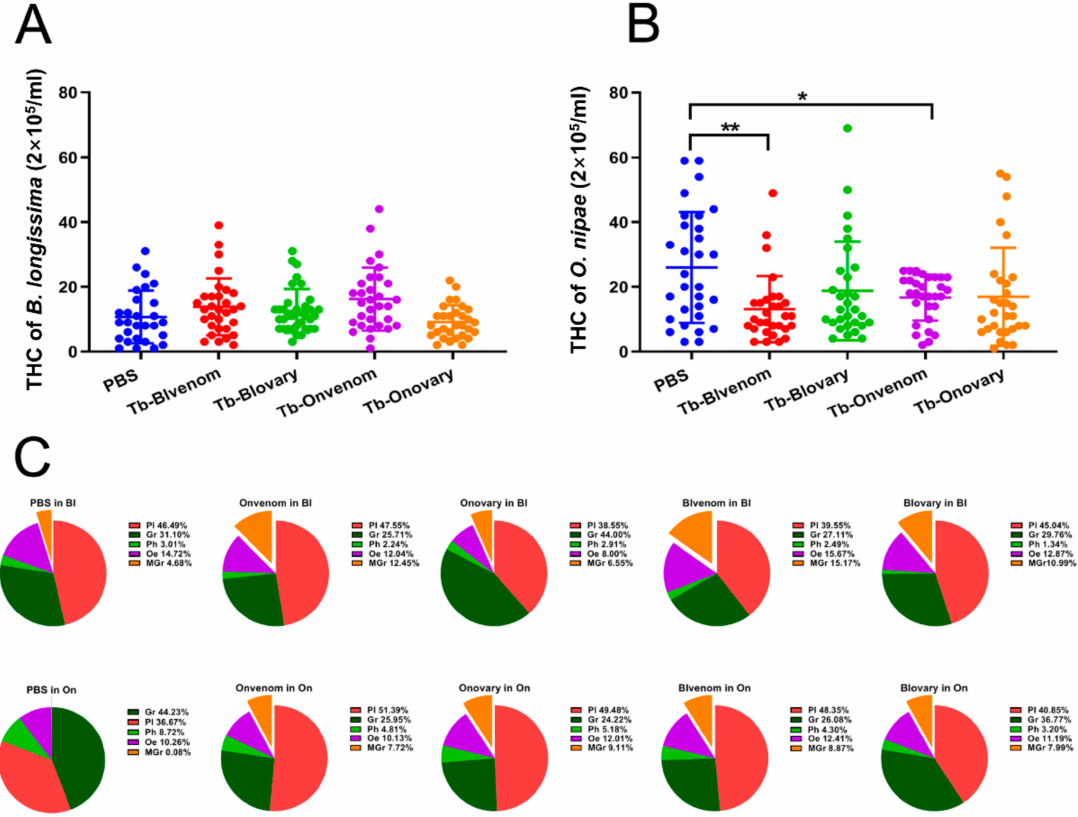
Figure 1. Comparison of cytotoxicity of venom or ovarian fluids injection against O. nipae and B. longissima pupae. ( A , B ) Total haemocyte counts (THCs) and ( C ) differential haemocyte counts (DHCs) of host pupae at 24 h after injection with venom or ovarian fluids. * and ** represent a significant difference at the p < 0.05 level and p < 0.01 level, respectively (Welch’s/Brown-Forsythe ANOVA followed by Dunnett’s T3